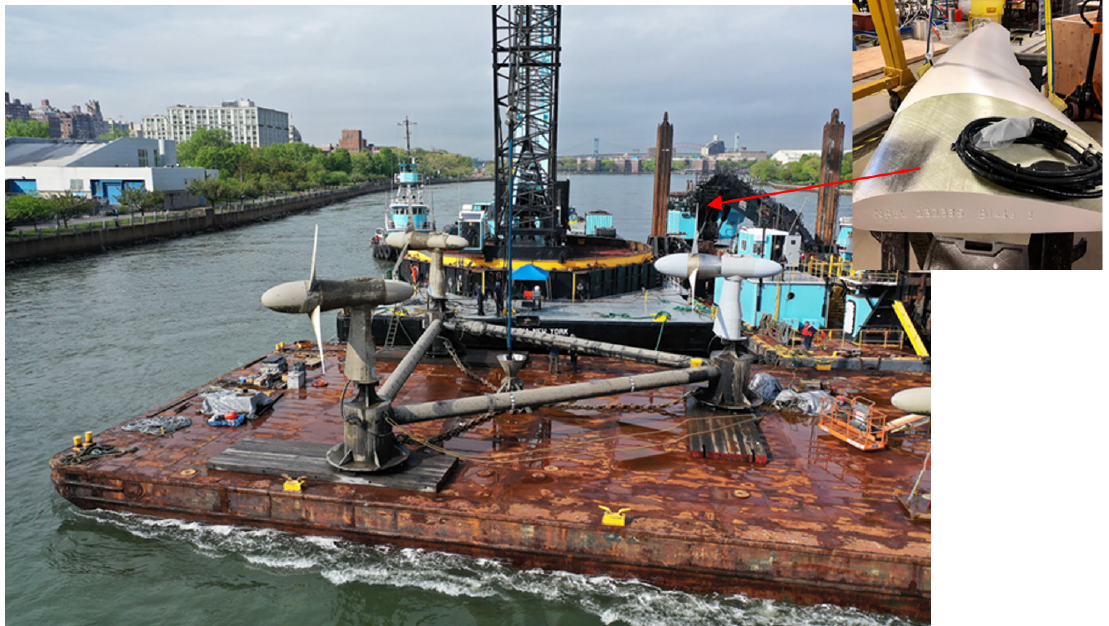
Figure 1. Verdant Power’s TriFrame being deployed in the East River in New York, with the Na- tional Renewable Energy Laboratory’s (NREL’s) thermoplastic blades on the turbine in the right side of the photograph. A close-up photograph of one thermoplastic blade is shown, indicated by the